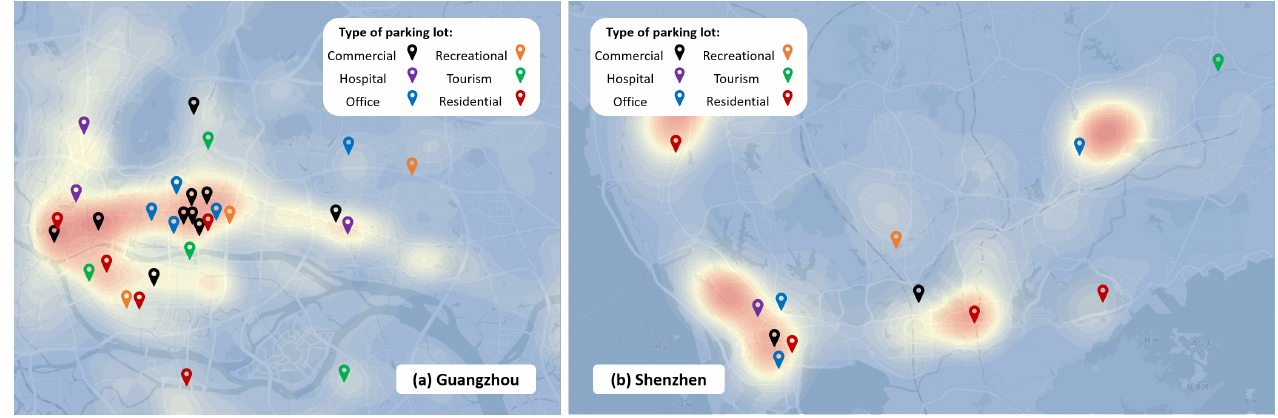
Figure 5. Spatial and category information of parking lots, ( a ) Train tasks; ( b ) Target tasks.